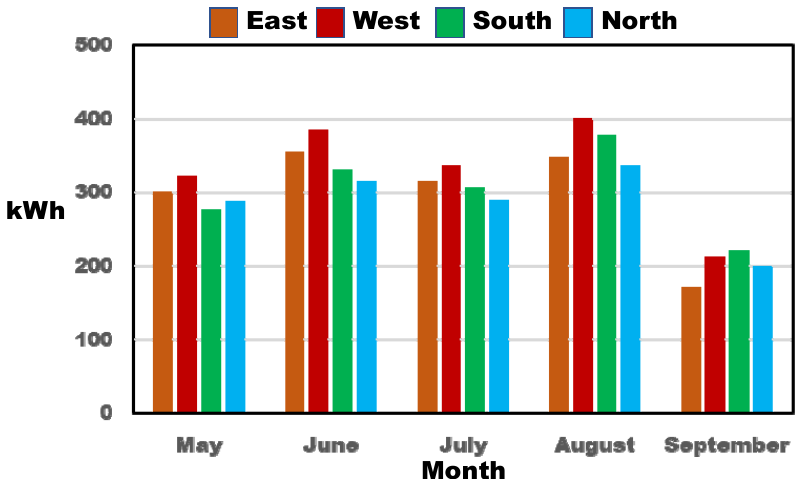
Figure 6. Cooling loads per building orientation during the summer. Table 5. The cooling loads during the summer by building orientation.